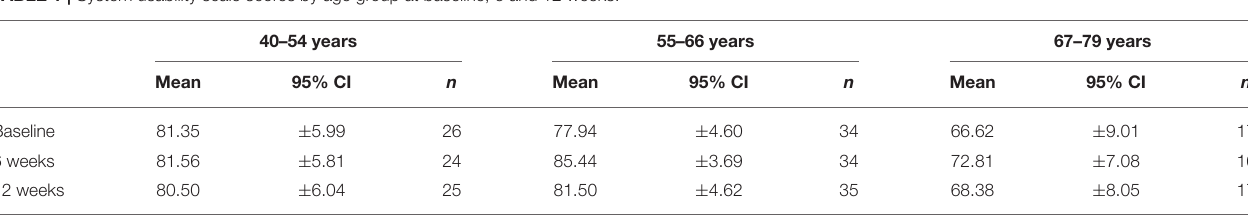
TABLE 1 | System usability scale scores by age group at baseline, 6 and 12